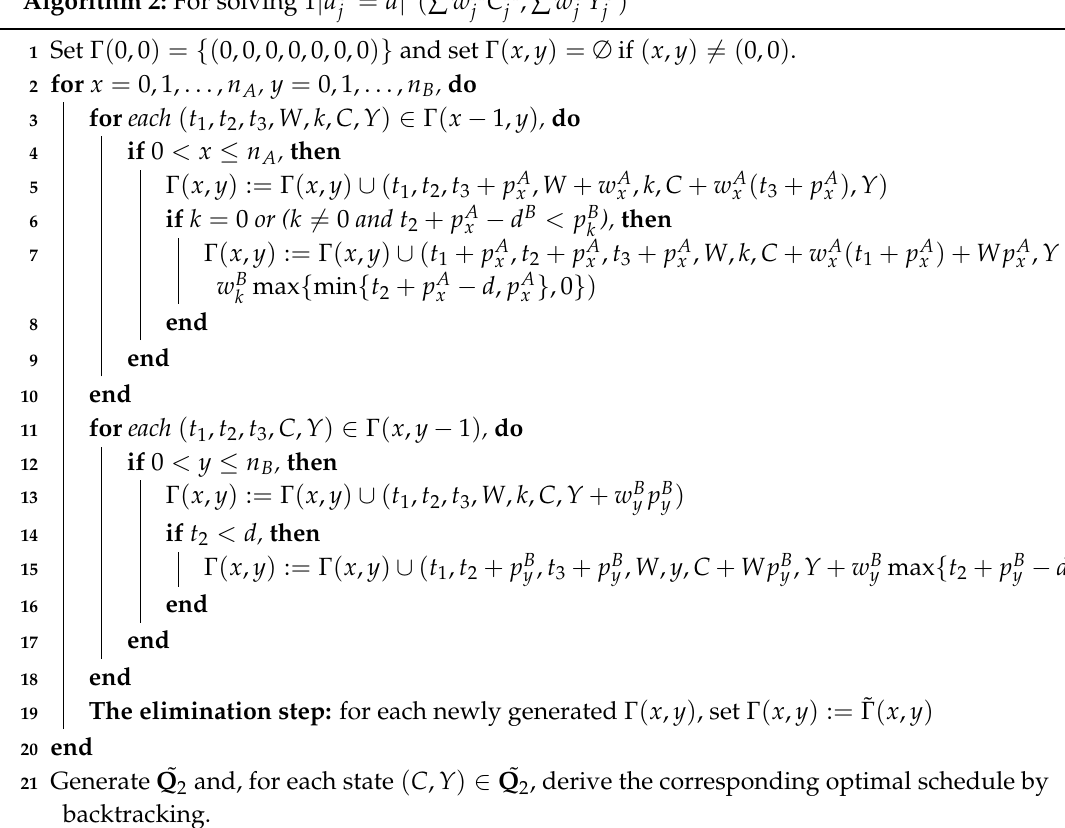
Algorithm 2: For solving 1 | d B